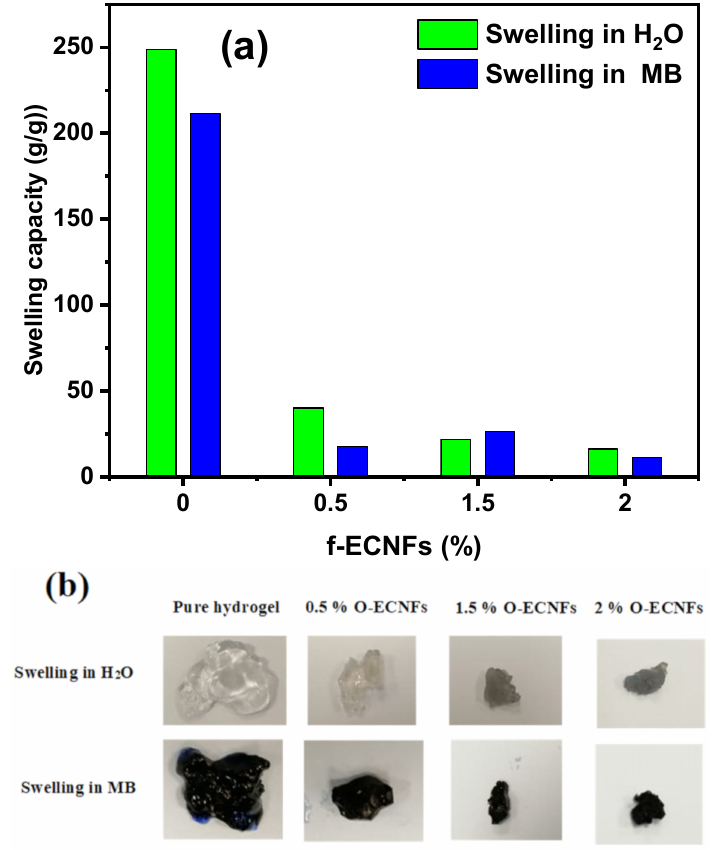
Figure 6. ( a ) E ff ect of O-ECNFs ratio on the swelling capacity of the prepared hydrogel ( b ) photograph of CT- g -PAA hydrogel and CT- g -PAA / O-ECNFs hydrogel nanocomposite after swelling in H 2 O and methylene blue